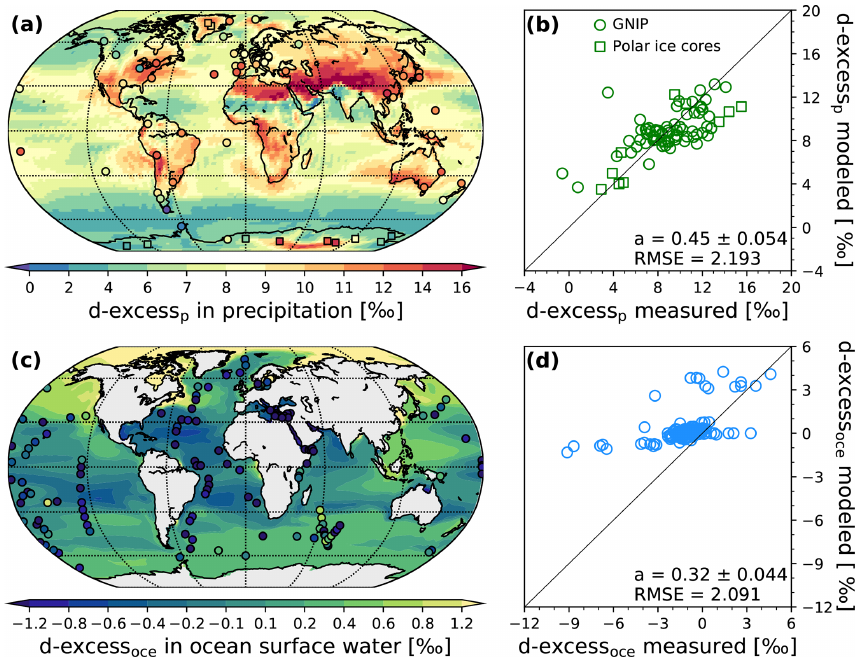
Figure 4. Global distribution of simulated and observed annual mean d-excess values in precipitation (a) and ocean surface waters (c) . Scatter plots of modeled vs. observed annual mean deuterium-excess values in precipitation (b) and ocean surface waters (d) are shown. The gradients and RMSE of the linear regression fits are given in the